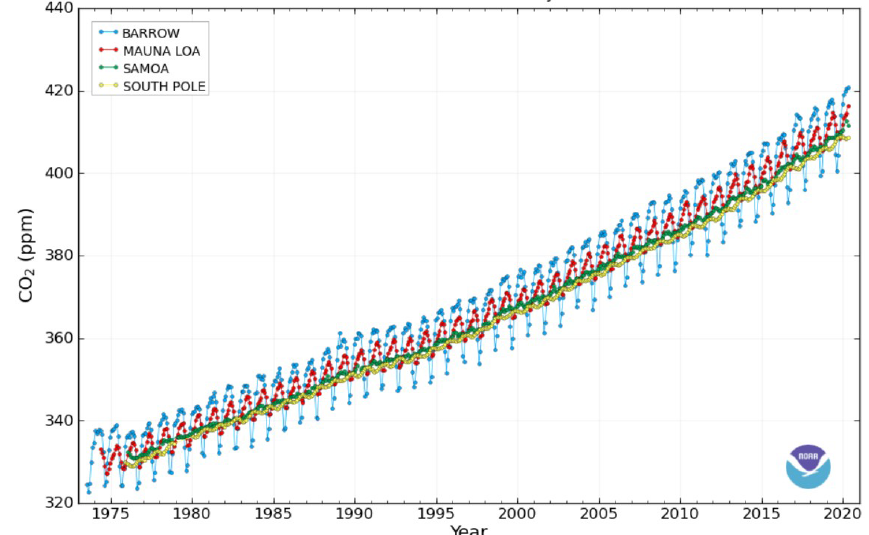
Figure 1. Long-term time series of CO 2 at the Mauna Loa, Barrow, American Samoa, and South Pole observatories (adapted from https: //gml.noaa.gov/, last access: 11 June 2022).